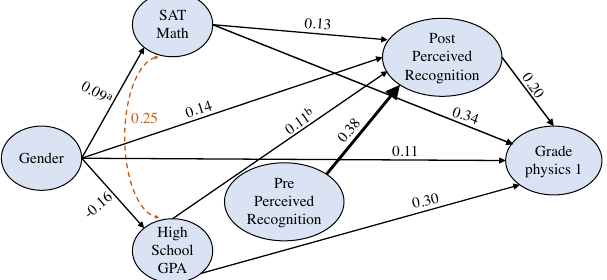
FIG. 3. Result of the path analysis part of the SEM between gender and physics 1 grade through students ’ perceived recog- nition as a physics person. The line thickness indicates the relative magnitude of β values. The dashed line indicates covariances between constructs. All p values are indicated by no superscript for p < 0 . 001 , superscript “ a ” for p ¼ 0 . 025 , and superscript “ b ” for p ¼ 0 . 001